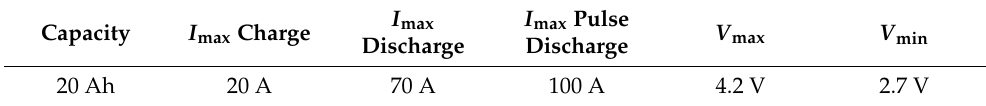
Table 1. Specification of pouch cell used in the